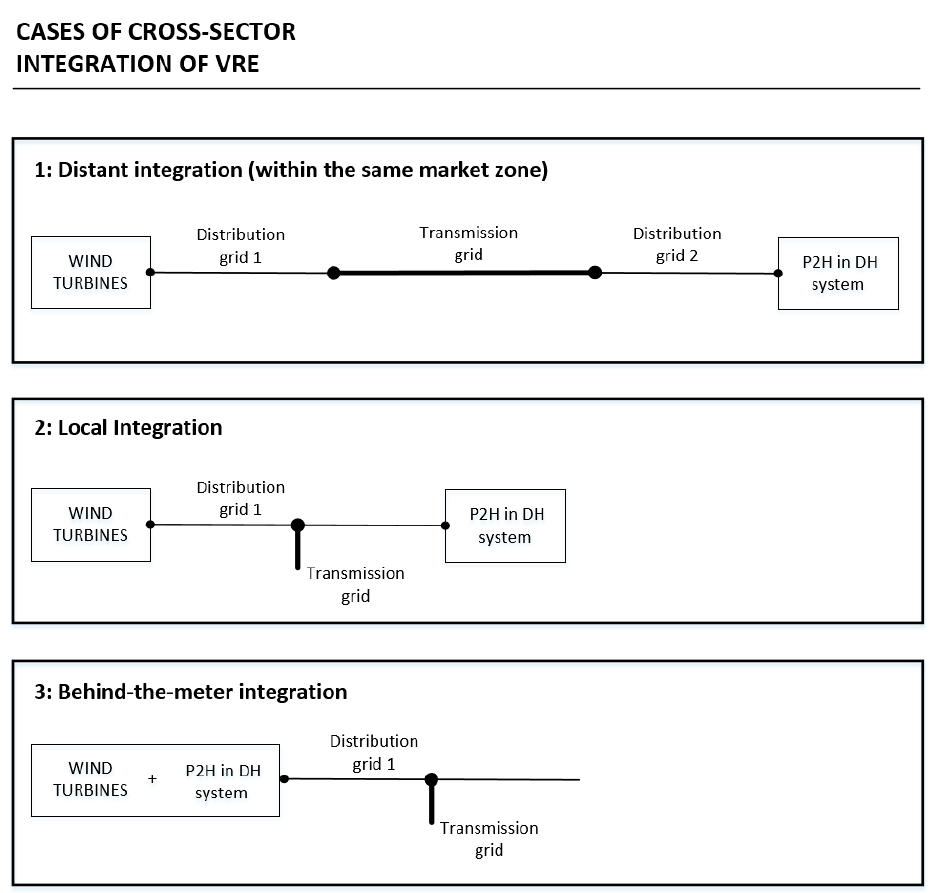
Figure 2. The location cases of cross-sector integration considered for the analysis. The location cases should not be regarded as either/or alternatives as they already co-exist and will probably still do so in the future. VRE: variable renewable energy; P2H: power-to-heat.